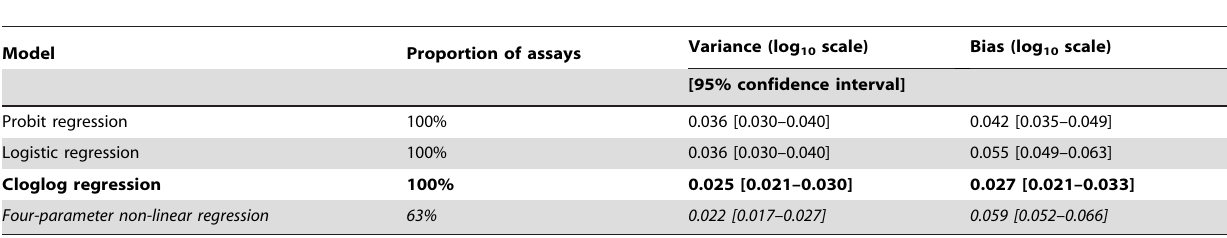
Table 2. Estimated standard deviation and bias in PRNT 75 estimates using the different